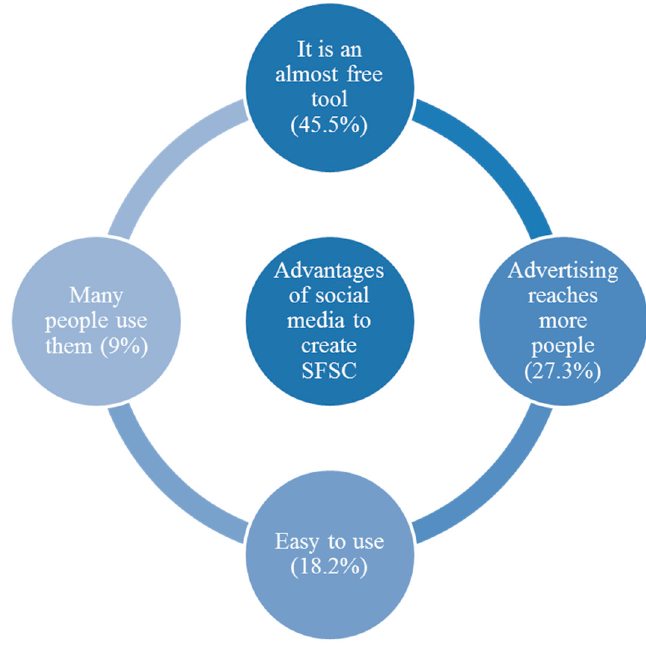
Figure 2. Advantages that enable social media to create SFSCs.